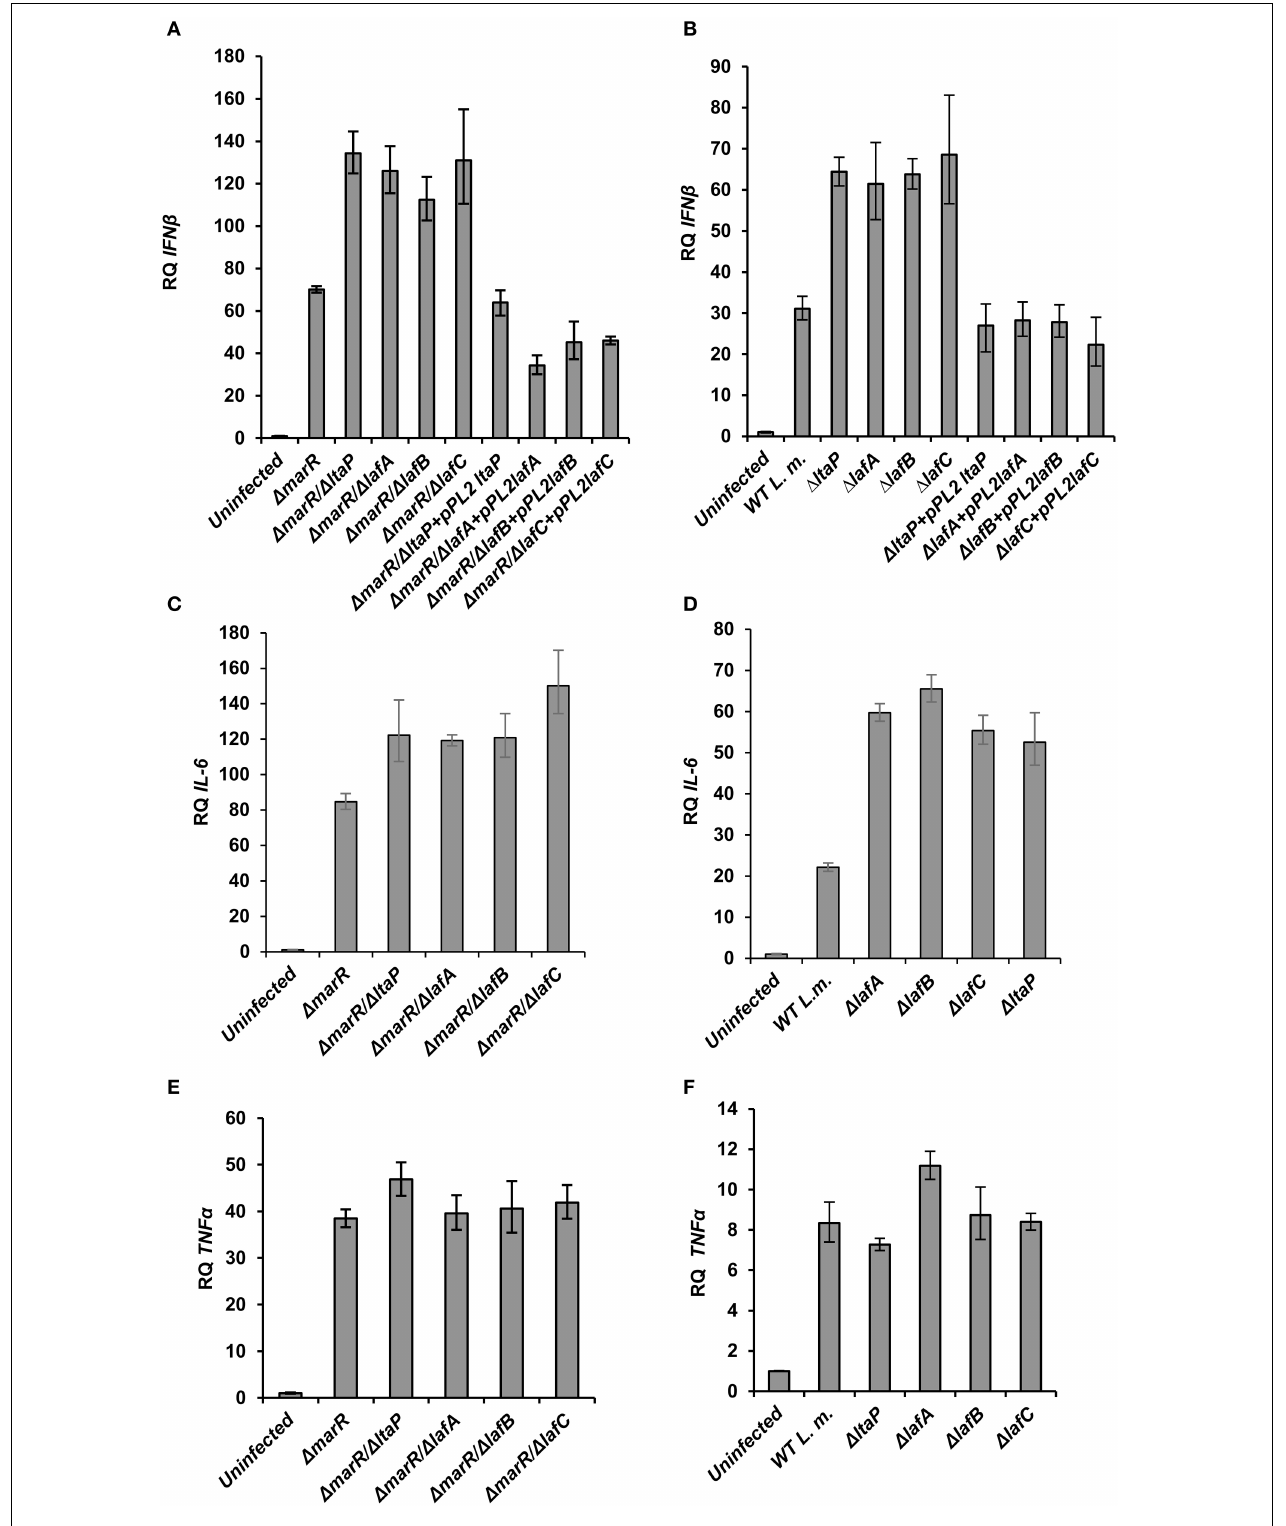
(cid:2) lafB , (cid:2) lafC ) in the background of WT or (cid:2) marR and corresponding complemented strains. Transcription levels are represented as relative quantity (RQ), relative to the levels in uninfected cells. The data represent three biological repeats ( N = 3). Error bars indicate 95% confidence interval, as described in the Materials and Methods ( P < 0 .